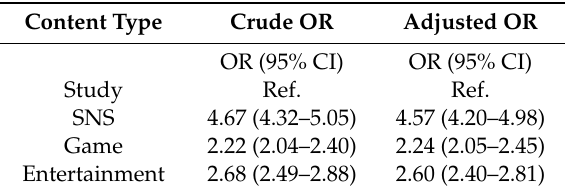
Table 5. Multivariable logistic regression analysis of content type of smartphone use, for smartphone overuse (more than 5 h per